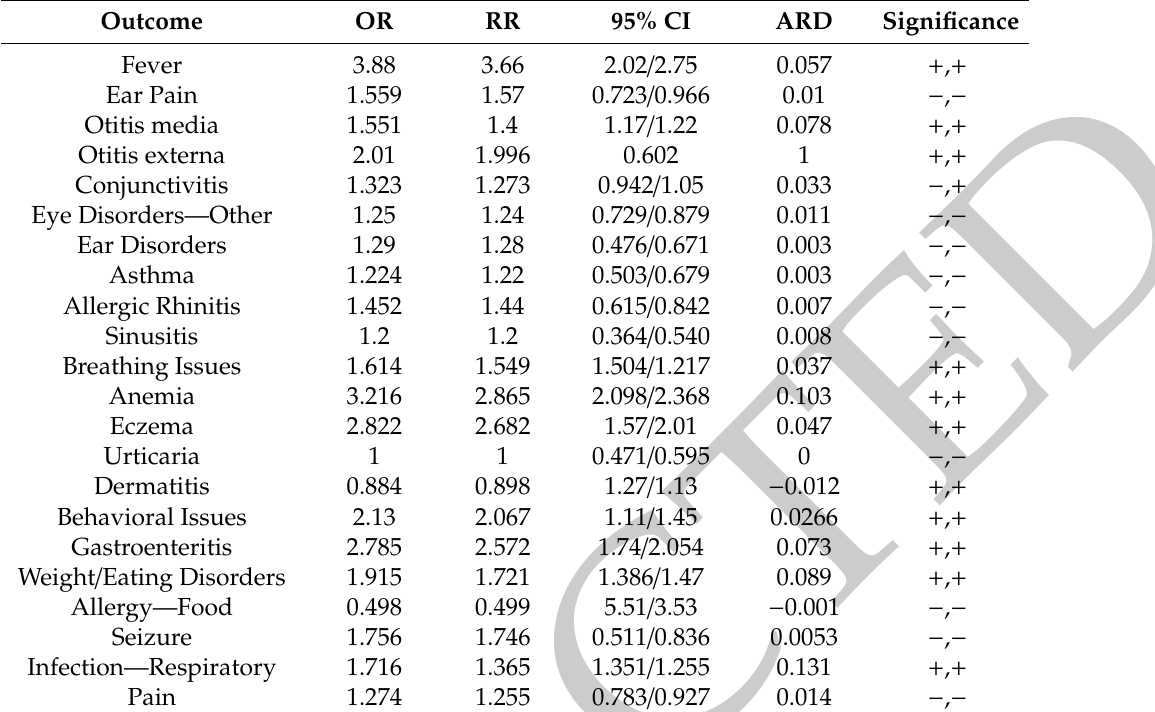
Table 5. Analysis 4: DOC-matched incidence